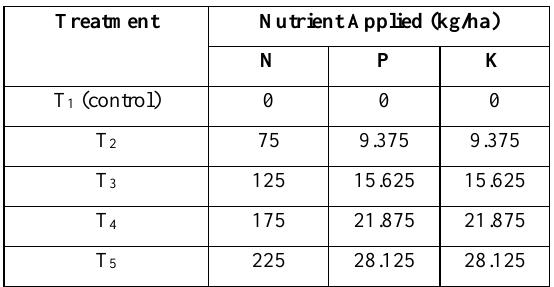
Figure 2. Sampling technique for Variable-Rate Fertilizer Treatments